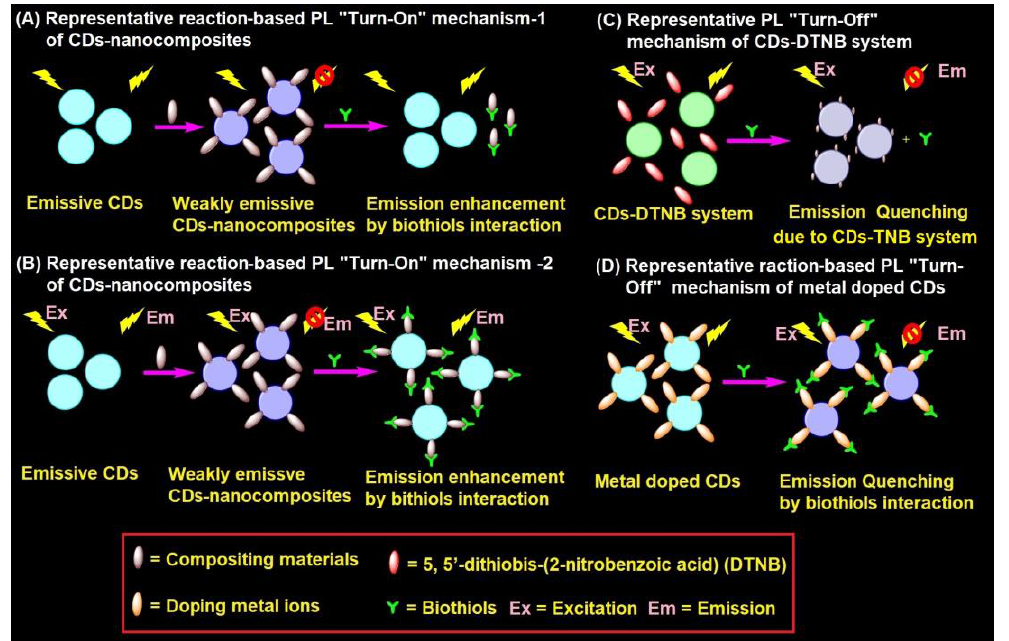
Figure 3. Representative ( A , B ) reaction- based PL “Turn - On” mechanism -1 and mechanism-2 of CD – nanocomposites, ( C ) PL “Turn - Off” mechanism of CD– DTNB system, and ( D ) reaction-based PL “Turn - Off” mechanism of metal doped CDs in the biothiols assay.